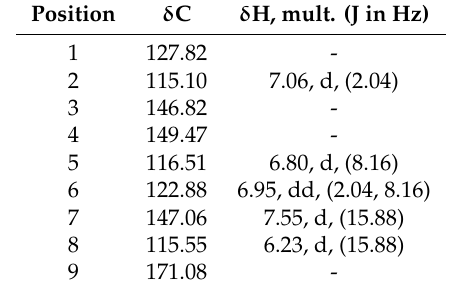
Table 1. NMR spectroscopic data of caffeic acid in CD 3 OD.